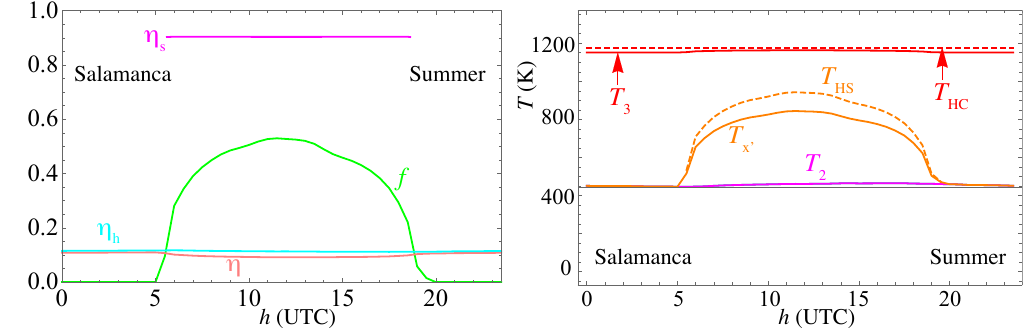
Figure 7. Plant efficiencies and temperatures without recuperation for the location at Salamanca during a summer day (13 June 2018). This figure should be compared with the right middle panels in Figures 5 and 6.